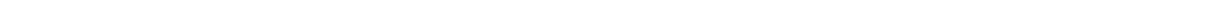
Fig. 3 Helraiser circle replication and donor site repair in HEK293T cells. a Schematic of the Helraiser heteroduplex LacZ donor plasmid (pHelR(mm)-Cam- LacZ) and resulting Helraiser circle. The red cross indicates the mismatch position within the transposon sequence, and the red circle marks the position of the mismatch used in the analysis of the Helraiser circles. b Experimental design of transposon circle replication assay using heteroduplex pHelR(mm)- Cam-LacZ donor plasmid. As shown, Dpn I digestion of LMW DNA reaction products can be used to distinguish between transposition of the ( + ) strand and the ( − ) strand. c Proportion of the transposon circles containing precise LTS-to-RTS junctions before and after Dpn I digestion of electroporated LMW DNA. The data are presented as n = 3 biological replicates. d Results of the transposon circle replication assay with pHelR(mm)-Cam-LacZ plasmid. The data are presented as a mean ± s.e.m., n = 3 biological replicates. e Schematic representation of possible outcomes of the transposon circle replication assay with heteroduplex pHelR(mm)-Cam-LacZ donors. Purple line: ( + ) strand of transposon donor; green line: ( − ) strand of transposon donor; solid line: methylated DNA; dashed line: unmethylated DNA; thin black line: plasmid